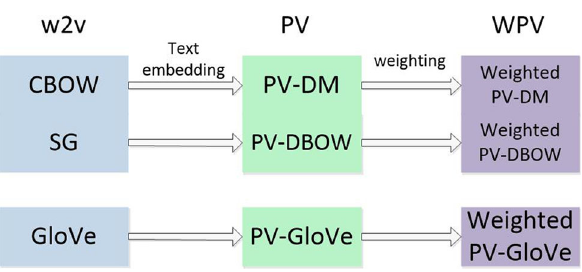
Fig. 1 Top ( bottom ): relationships among word2vec (GloVe), PV (PV-GloVe), and WPV